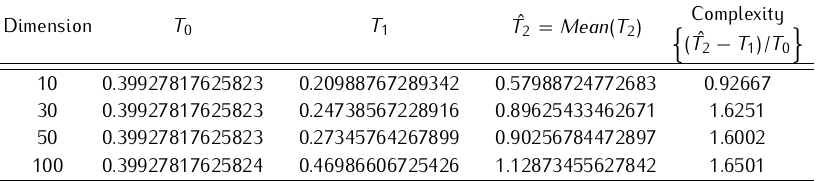
Table 4. Time Complexity of the SCA on Rosenbrock function.